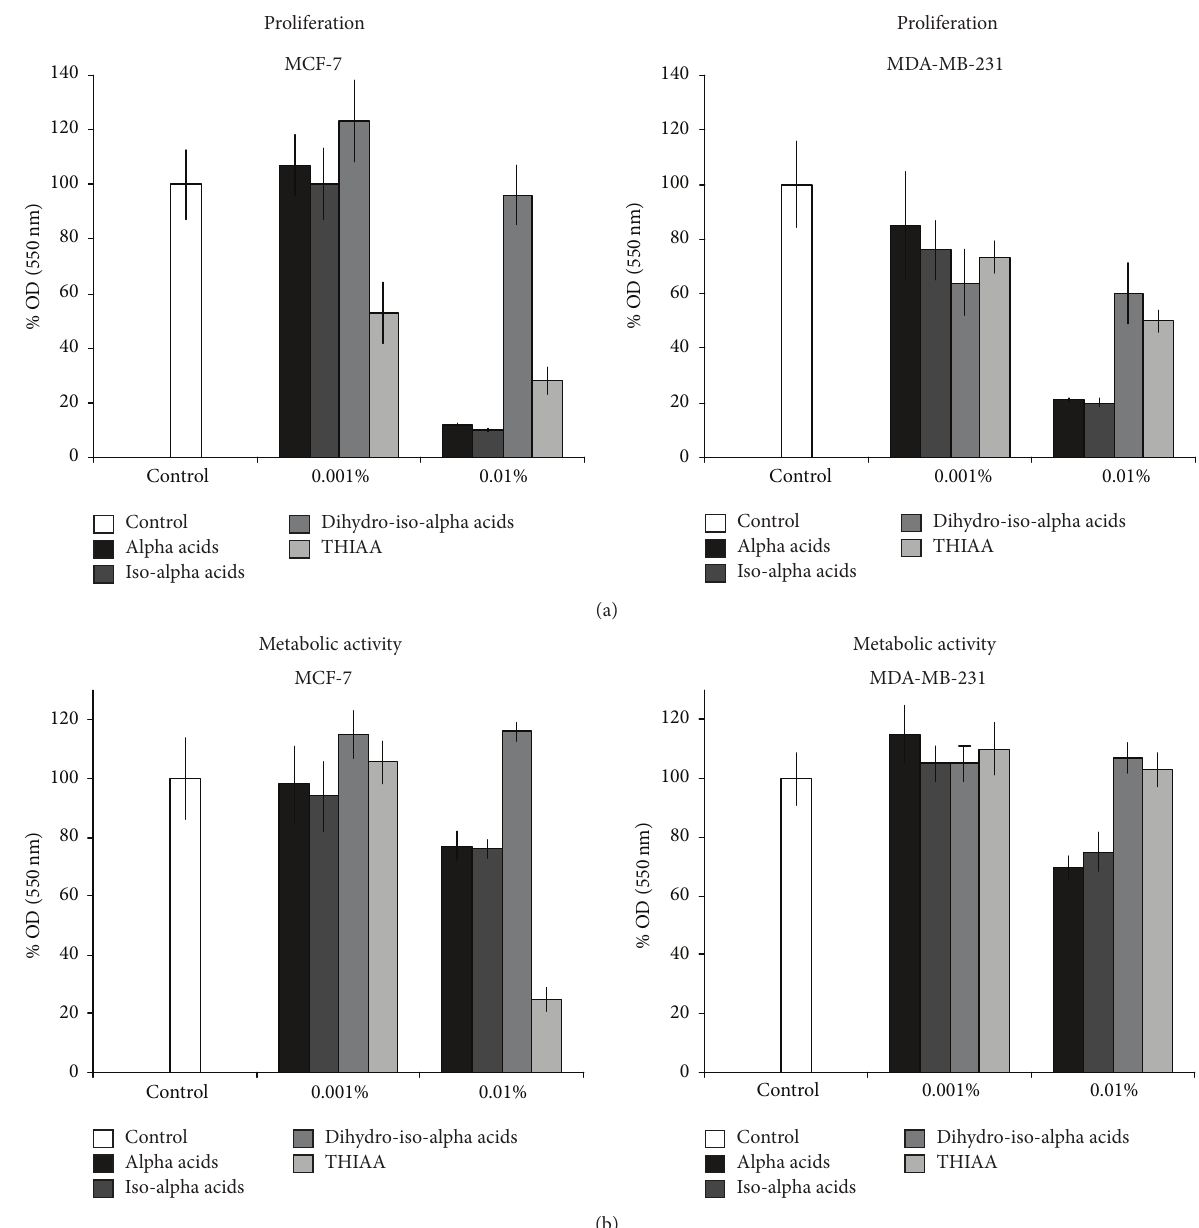
Figure 2: Effect of commercial hop extracts on proliferation (a) and metabolic activity (b) of MCF-7 and MDA-MB-231 cells in serum- complete condition. Cells were grown during 72 h in the absence (control) or presence of indicated hop extracts at 0.001 and 0.01%. Cell proliferation was measured by crystal violet staining and metabolic activity by the MTT method. Measurements were performed in sixplicate. Data refer to the mean value ± SD of a representative experiment performed independently three